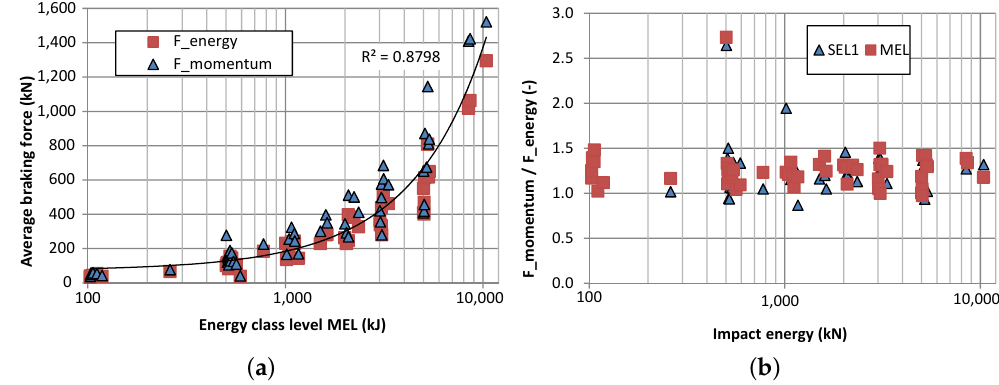
Figure 8. ( a ) Average braking forces for MEL tests based on momentum and energy approach; ( b ) relation between momentum and energy approach for Service Energy Level 1 (SEL1) and MEL